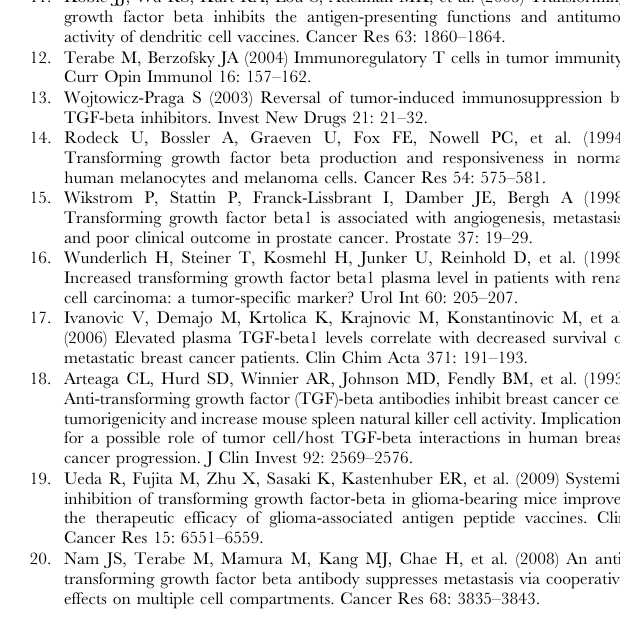
GC1008. Biopsies were consistent with keratoacanthomas. Figure S2 Non-target melanoma lesion from a respond- ing patient. Biopsy from patient 007 revealed tumor central necrosis and a lymphocytic infiltrate on hematoxylin-eosin stain. Additional immunohistochemical stains (not shown)